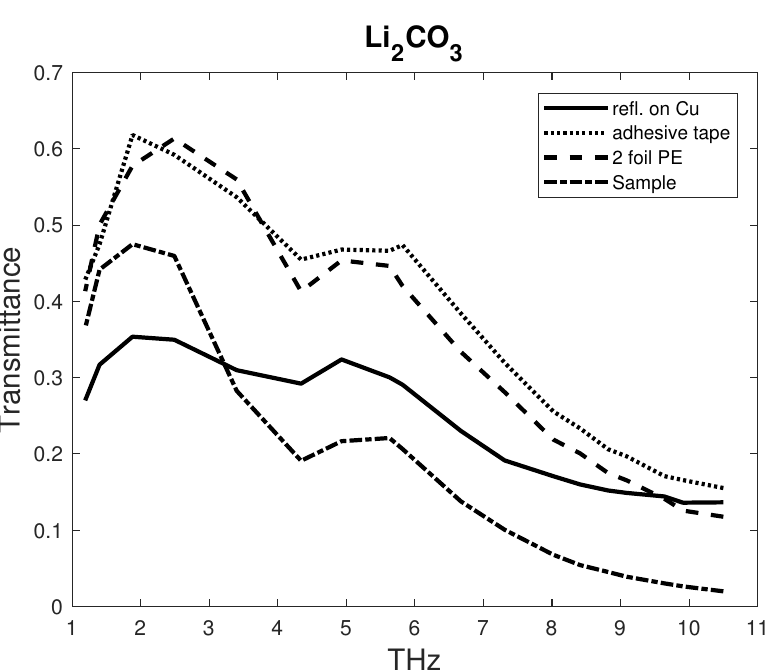
Figure 6. The MFA used to test different typologies of sample preparation for Li 2 CO 3 : Solid line: the material is on a flat copper surface. Dotted line: the powder is on adhesive tape. Dashed line: the powder is between two thin sheet of polyethylene. Dashed-dot line: the powder is inglobate in High-density polyethylene (HDPE) (the stable sample